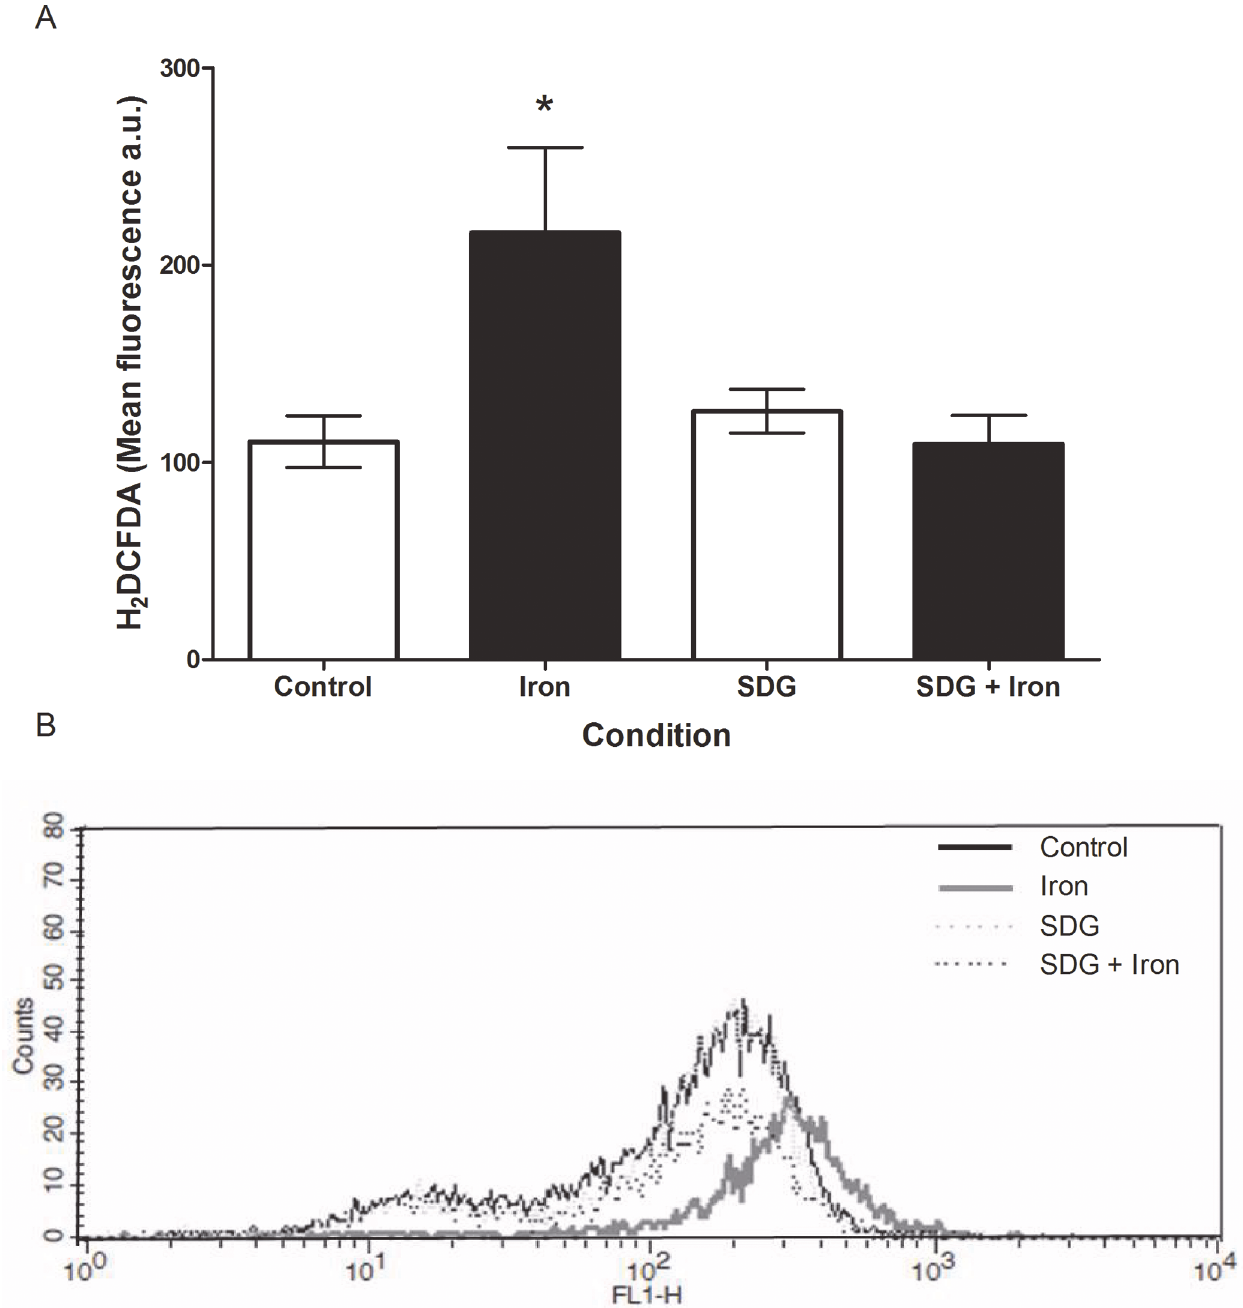
Fig 2. SDG decreases iron-induced oxidative stress in H9c2 cells. Reactive oxygen species (ROS) in control, 50 μ M iron-treated, 500 μ M secoisolariciresinol diglucoside (SDG), and SDG pre-treatment + iron-treated H9c2 cells. ROS levels were assessed using the CM-H 2 DCFDA assay and measured via flow cytometry (A). The representative histogram of cell count versus FL1 fluorescence (B). Data is expressed as mean fluorescence arbitrary units (a.u.) ( * = p < 0.05 versus control, n = 3).